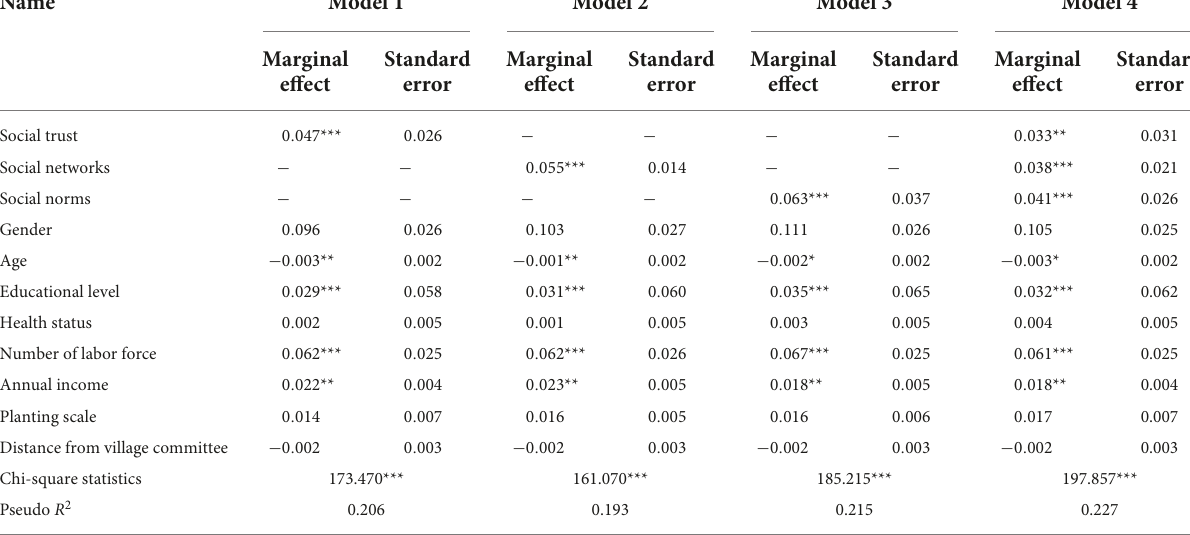
TABLE 5 Estimated results of the impact of social capital on farmers’ green control technology (GCT) adoption behavior (benchmark